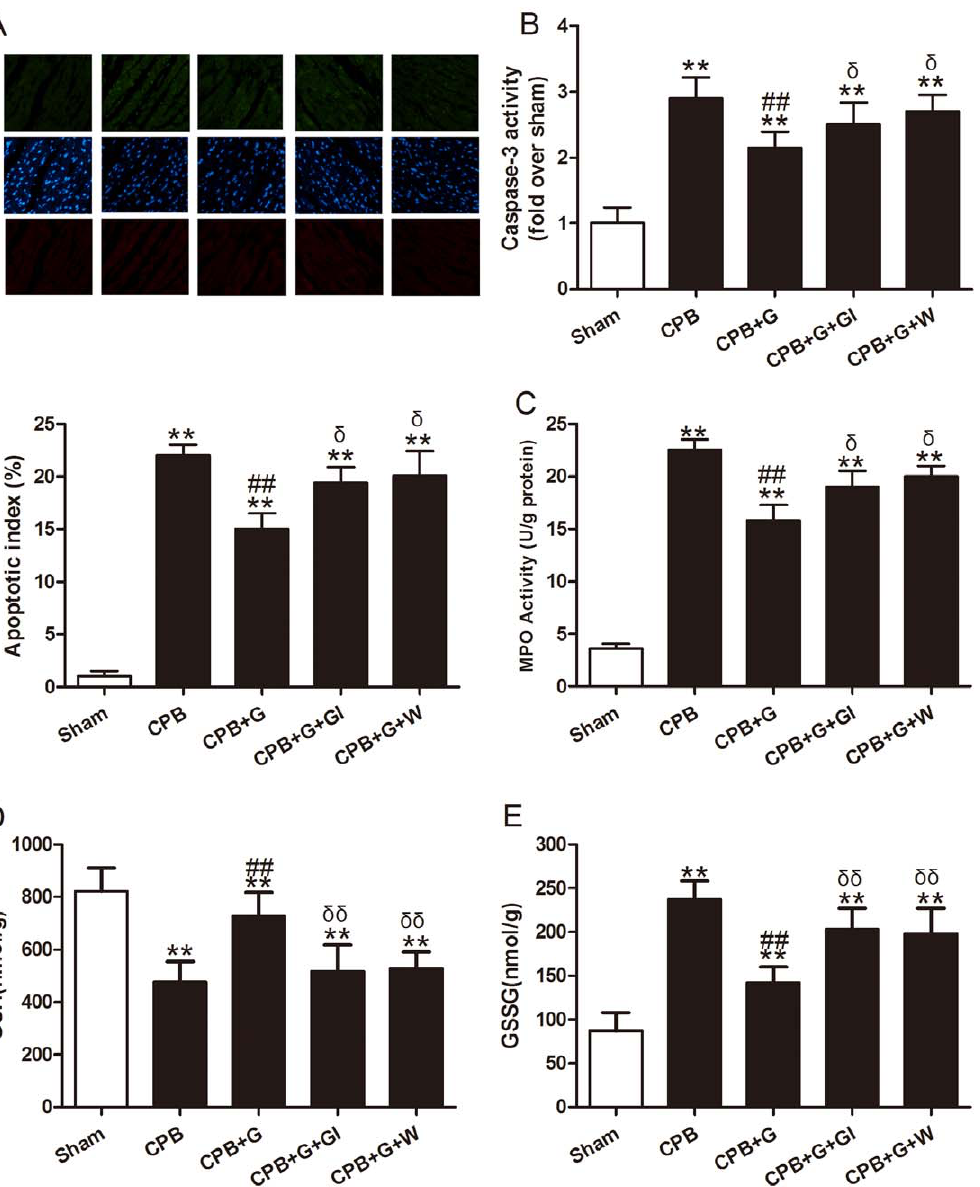
Figure 2. Myocardial apoptosis, MPO activity, reduced glutathione (GSH) and oxidized glutathione (GSSH) in rats subjected to cardiopulmonary bypass (CPB) with different treatments (n=8/group). A, top: representative photomicrographs of in situ detection of apoptotic myocytes by terminal deoxynucleotidyl nick-end labeling (TUNEL) staining in ischemic heart tissue from rats subjected to 60 min CPB. Green uorescence shows TUNEL-positive nuclei; blue uorescence shows nuclei of total cardiomyocytes. Bottom: percentage of TUNEL-positive nuclei in heart tissue sections. (x20 objective) B: myocardial caspase-3 activity. C: MPO activity. D: reduced glutathione (GSH). E: oxidized glutathione (GSSH). Values presented are mean 6 SEM. G, ghrelin; GI, [D-Lys3]-GHRP-6, ghrelin inhibitor; W, wortmannin, a PI3K inhibitor. ** P , 0.01 vs. Sham, ## P , 0.01 vs. CPB, d P , 0.05 vs. CPB + G.